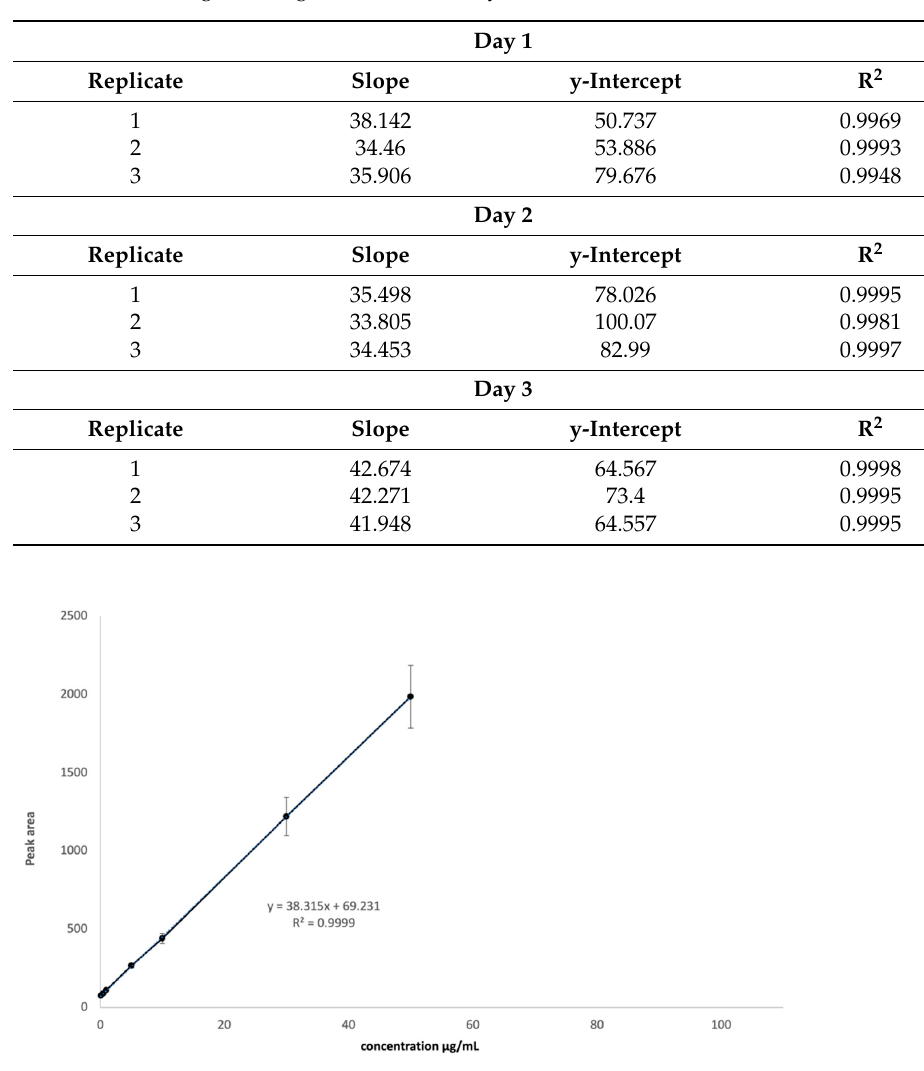
Table 2. Linear range investigated over three days.